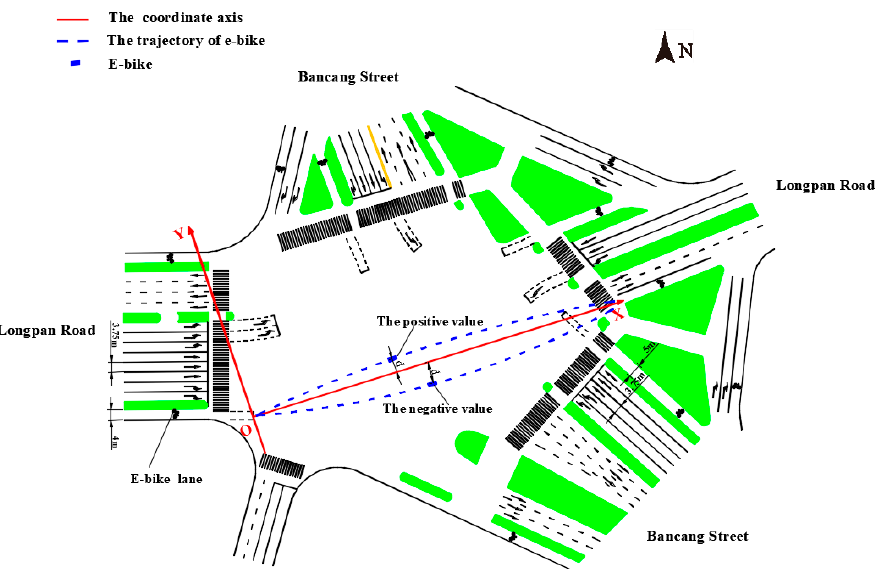
Figure 2. Schematic diagram of the expansion degree of a straight-going e-bike at an irregular signal intersection.